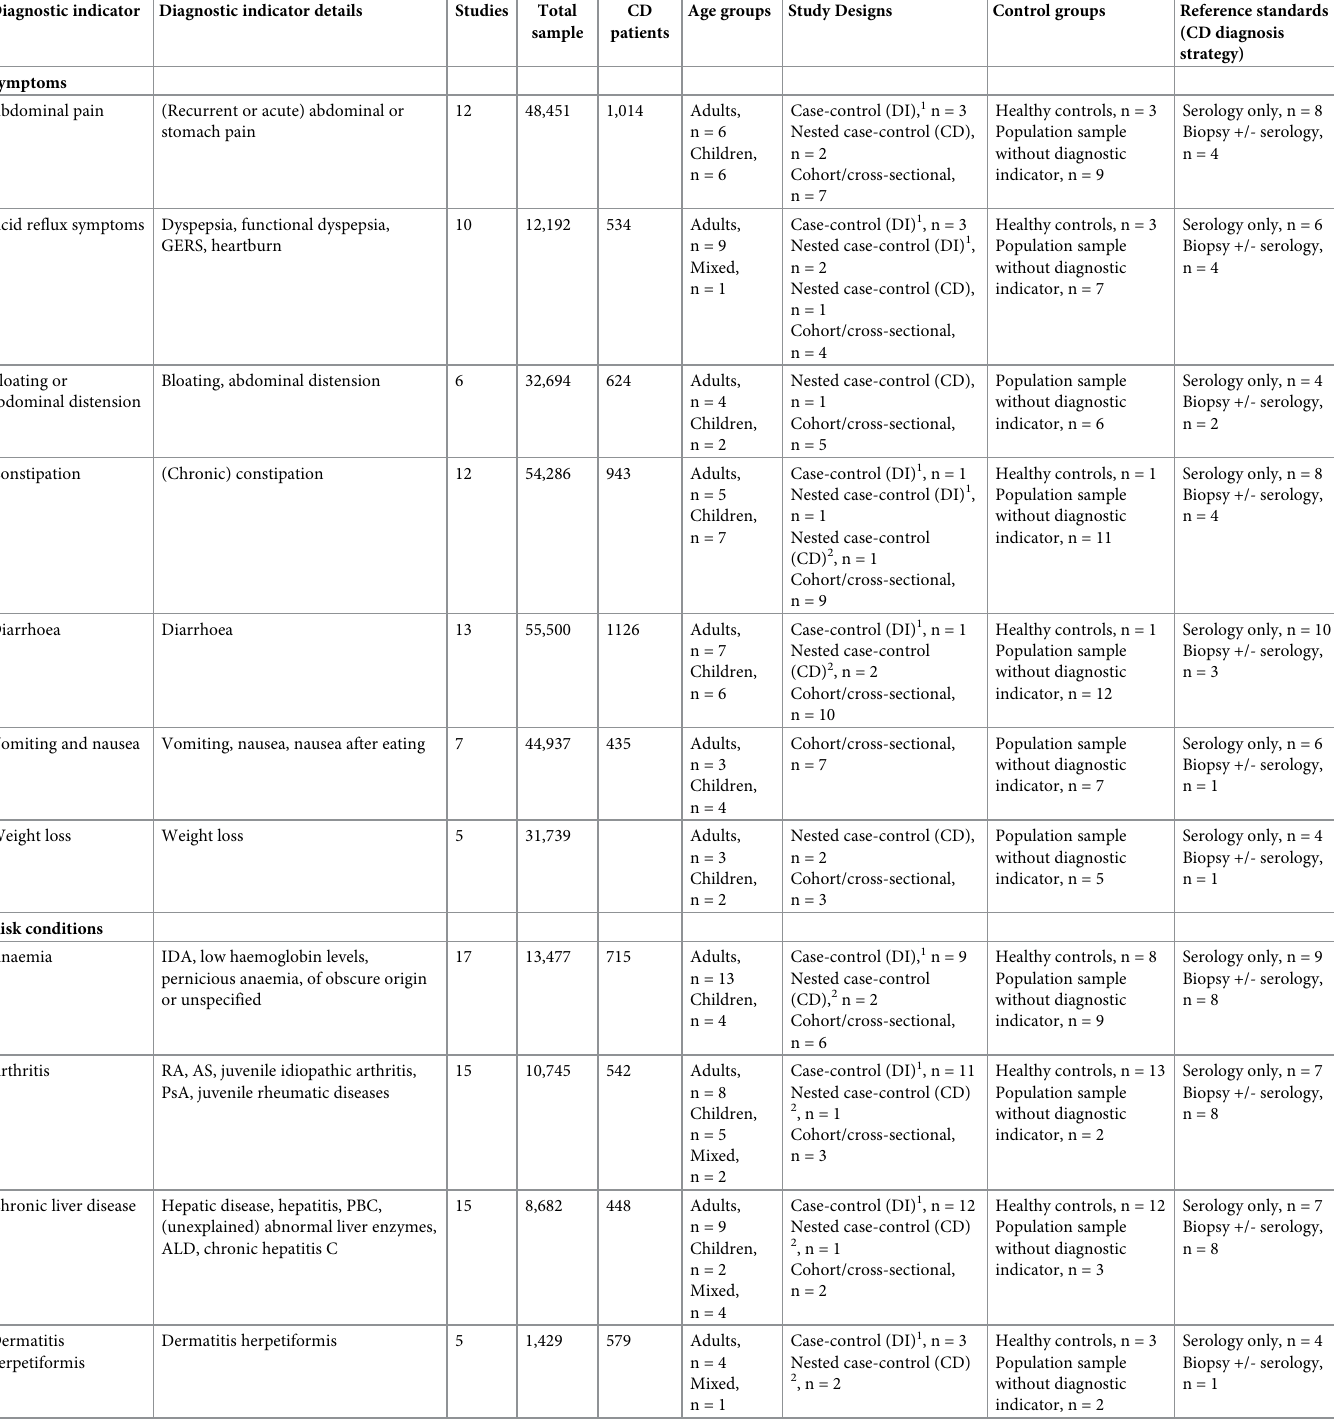
Table 1. Summary table of study